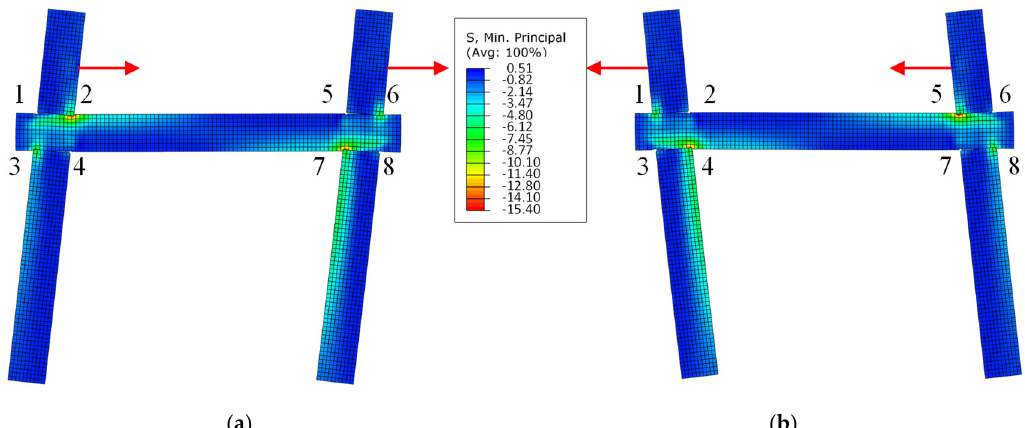
Figure 10. Minimum principal stress at the middle plane: ( a ) +180 mm; ( b ) − 180 mm.